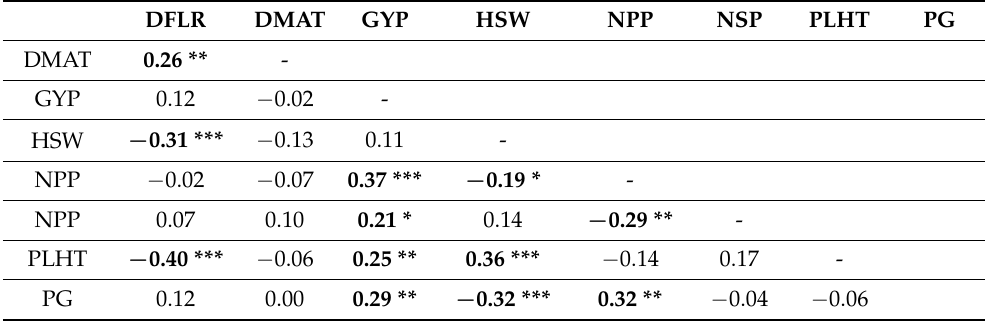
Table 4. Correlation analysis between mean phenotyping estimates for different phenotyping and physiological traits and regression equation between grain yield and associated